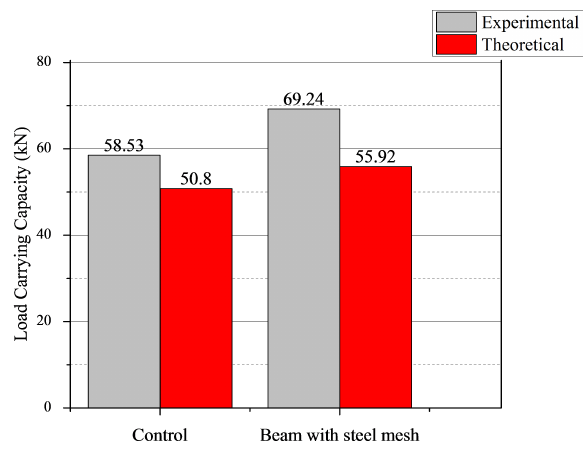
Figure 14: Load carrying capacity for control and beam retrofitted with steel